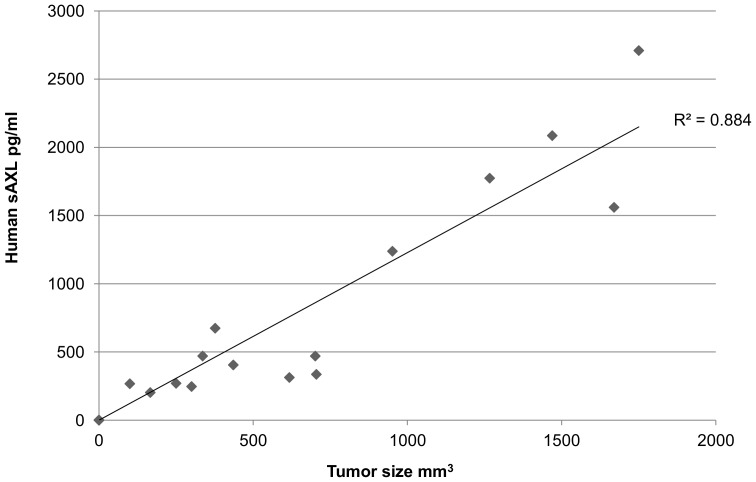
Mice harboring human MPNST (STS26T) xenograft tumors release human-soluble AXL into the blood.There was a trend of size dependent increasing of sAXL level until the tumors reached 2000 mm3. The coefficient of determination, R2 was 0.884.